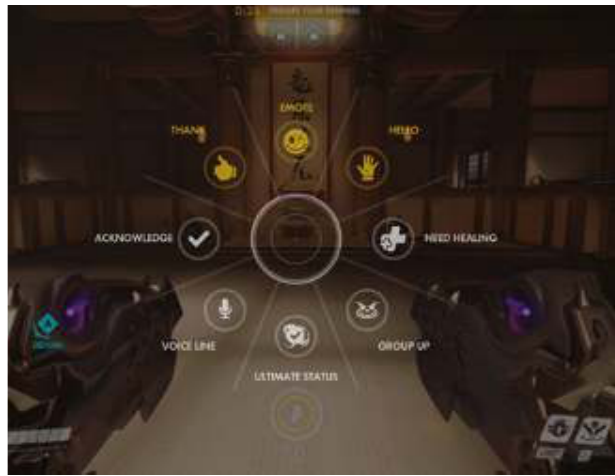
Player’s name has been obscured for anonymity. Credits: Overwatch . Blizzard